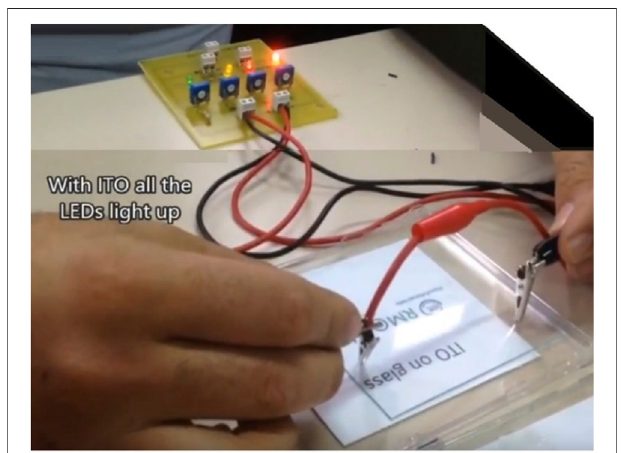
FIGURE 4 | Experiment on ITO substitution carried out with the printed circuit board realized by Class 4 and Class 5. This image is obtained by juxtaposing and matching two photograms of the movie (circuits in Supplementary Table 1 in Supplementary Info).